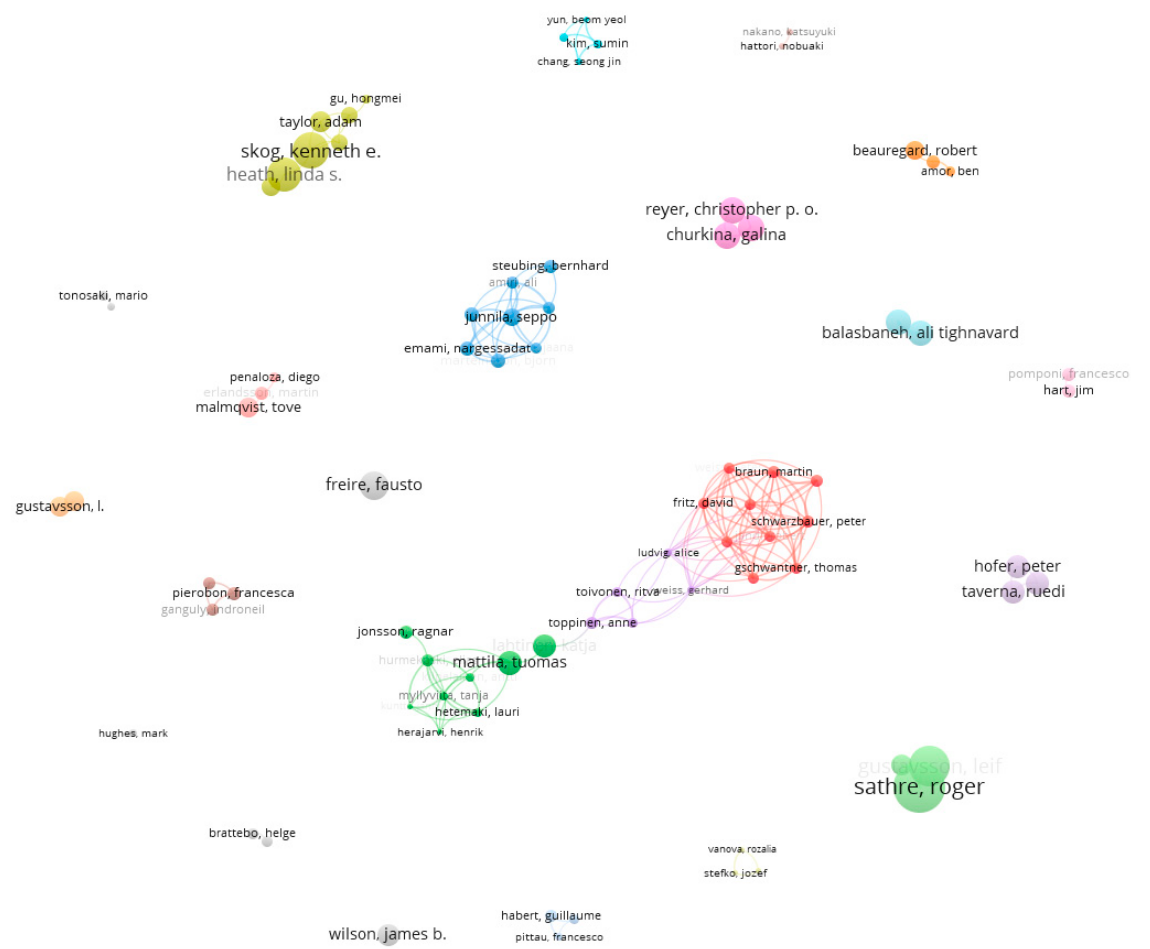
Figure 3. The co-authorship links of the authors.